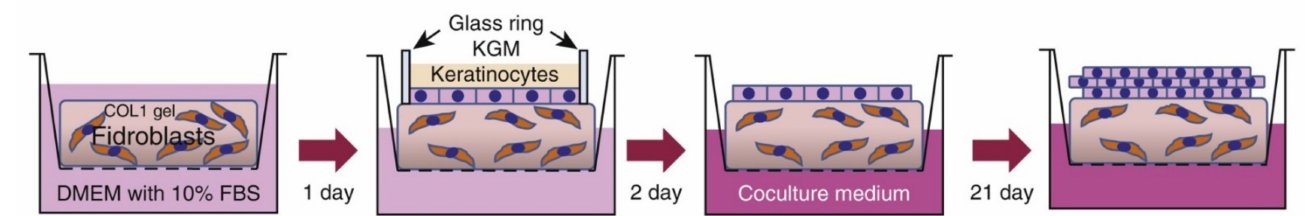
Figure 2. Schematic illustrating construction of an RDEB 3D HSE used for investigation of the role of latent TGF- β signaling activation in RDEB. Adapted with permission from [12], published by Nature Publishing Group,